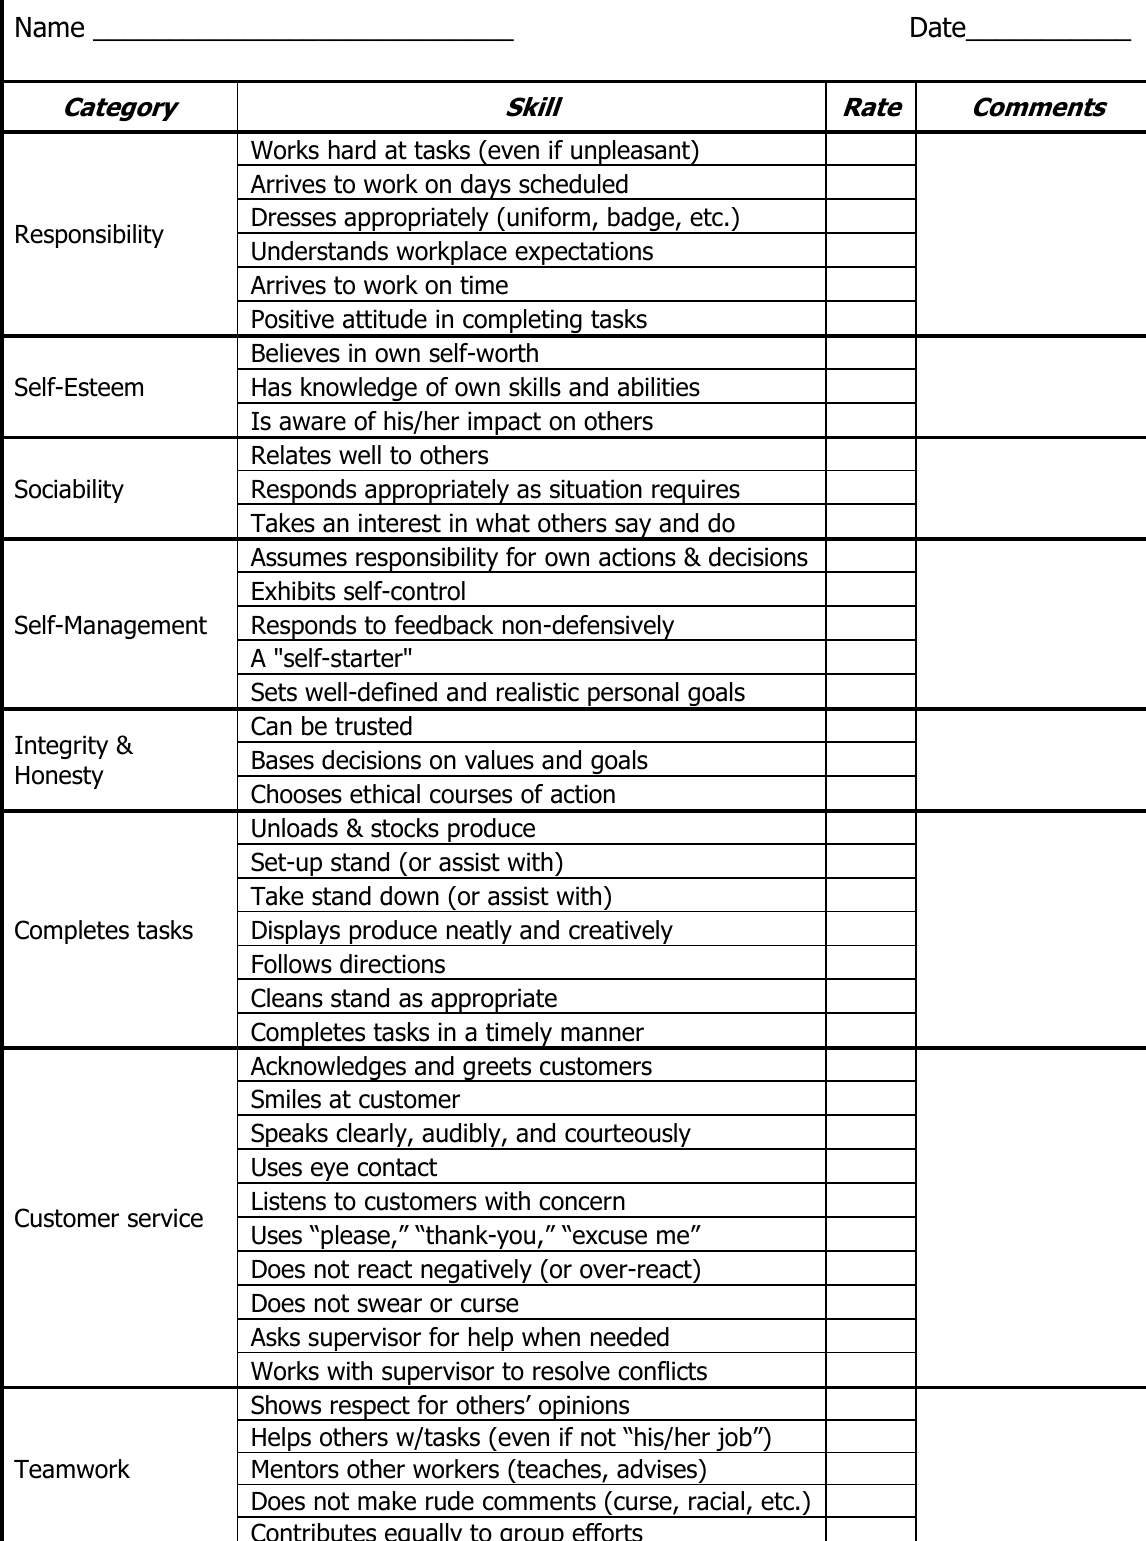
SCANS Skills and Competencies